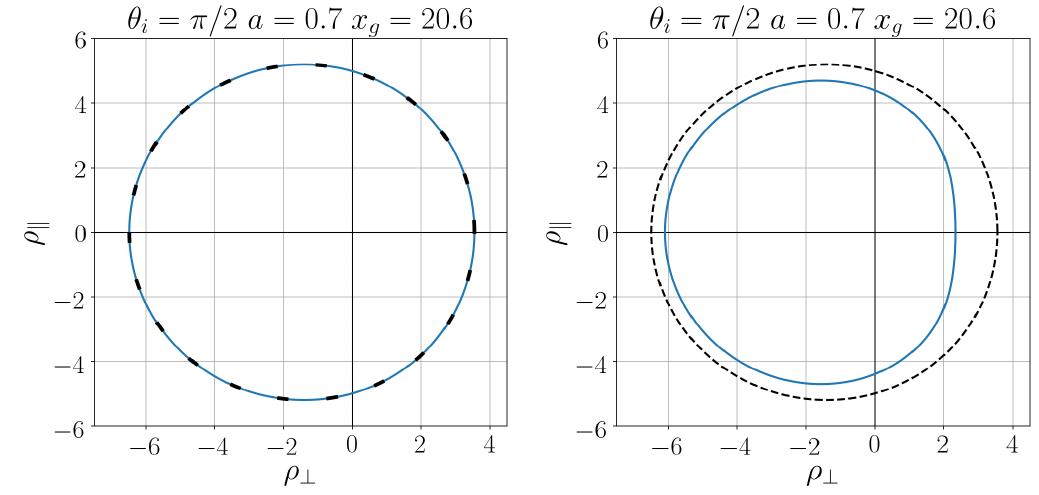
Figure 5. Left : Shadow of the black hole with the polarization profile (56) and of the Kerr black hole (dashed line) for a = 0.7. Right : Shadow of the black hole with the regularized Newtonian profile (58) and of the Kerr black hole (dashed line) for a =